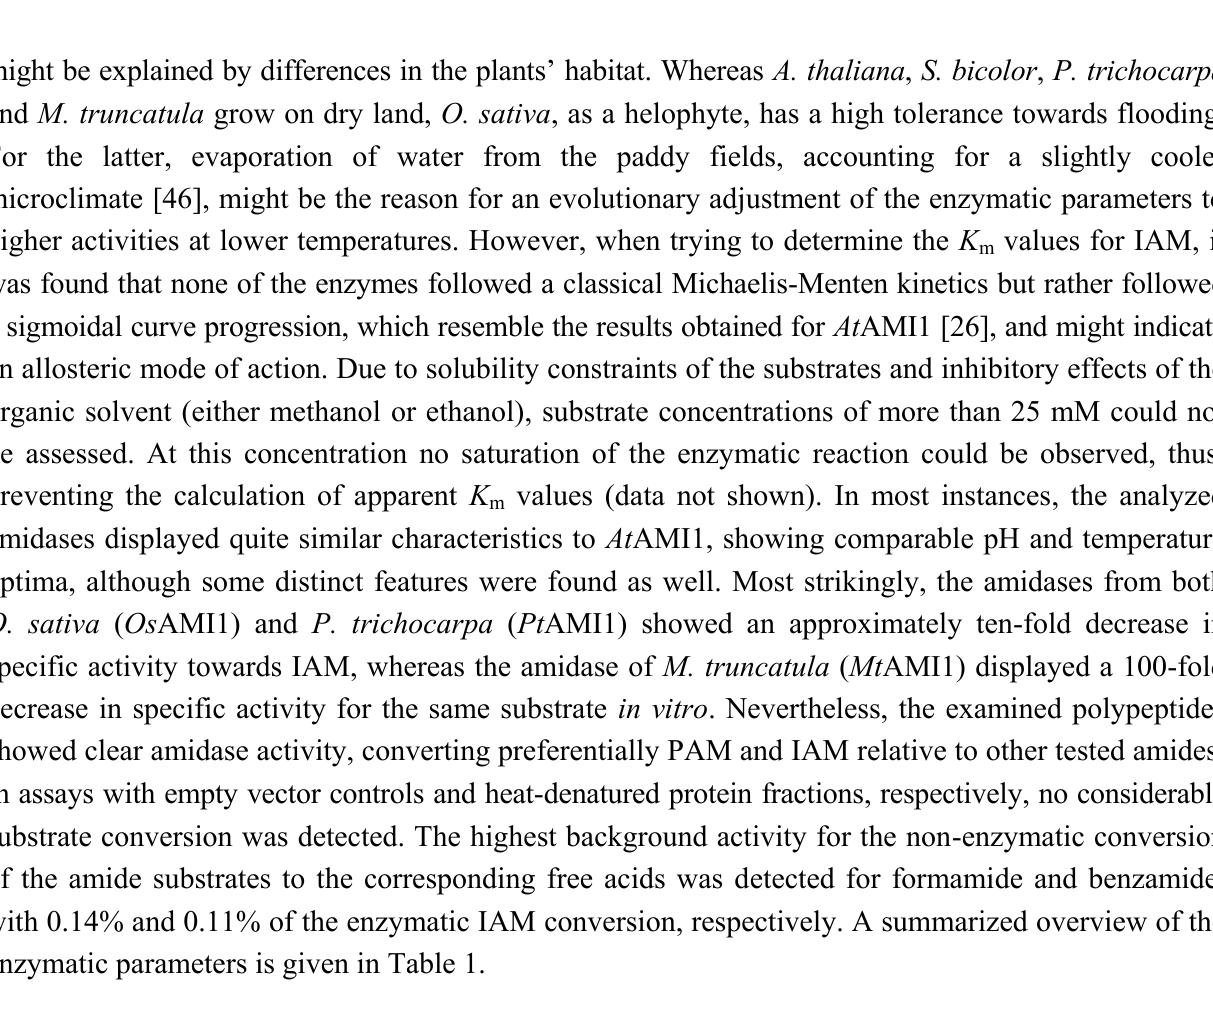
Table 1. Comparison of the enzymatic parameters obtained for recombinant amidases